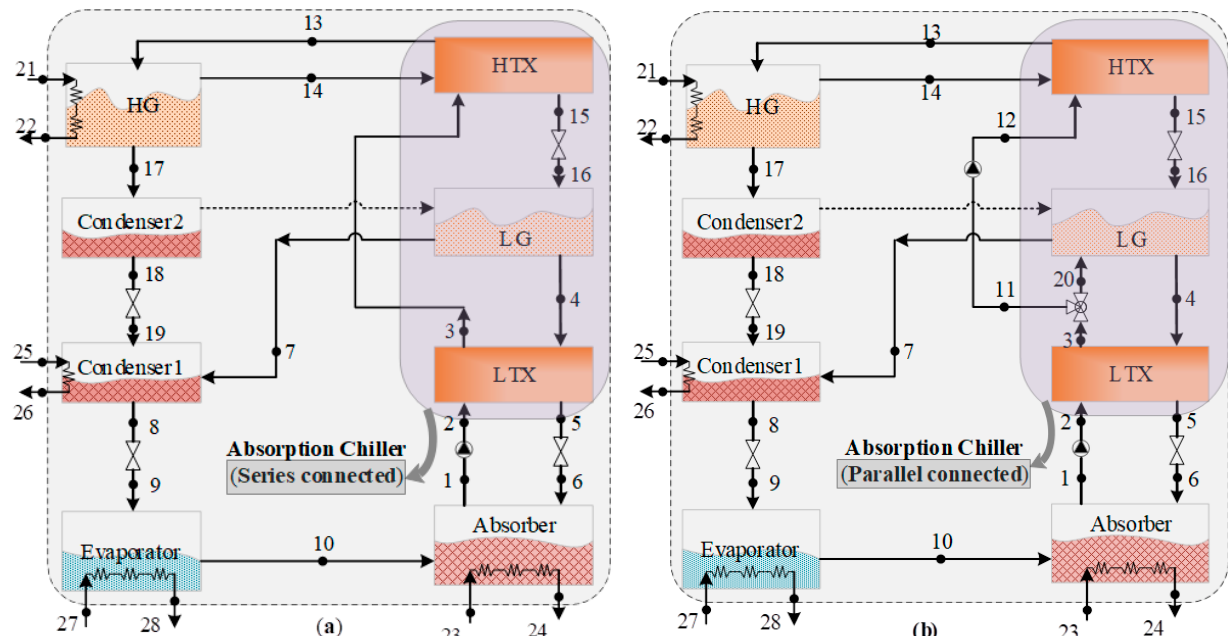
Figure 1. Energy flows in the absorption chillers ( a ) Series connected chiller, ( b ) Parallel connected chiller) (HG = High-pressure generator, LG = low-pressure generator, HTX = High-temperature heat exchanger, LTX = Low-temperature heat exchanger).